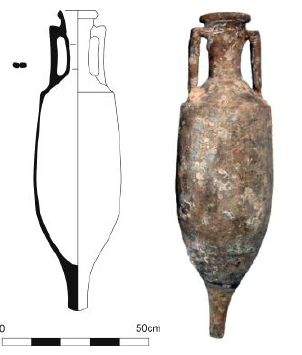
Figure 1. Archaeological drawing and a photograph of Roman Amphorae: “Dressel 2-4 Catalan”.